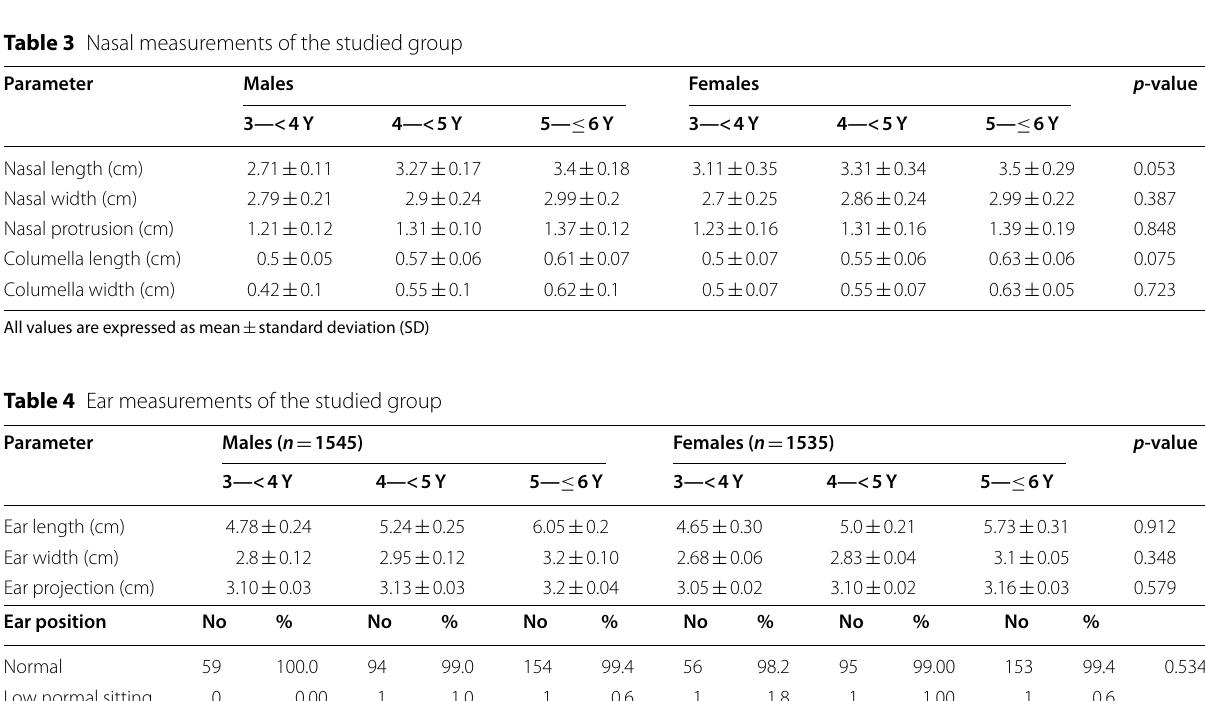
standard deviation (SD) (quantitative data) and No and % (qualitative data)